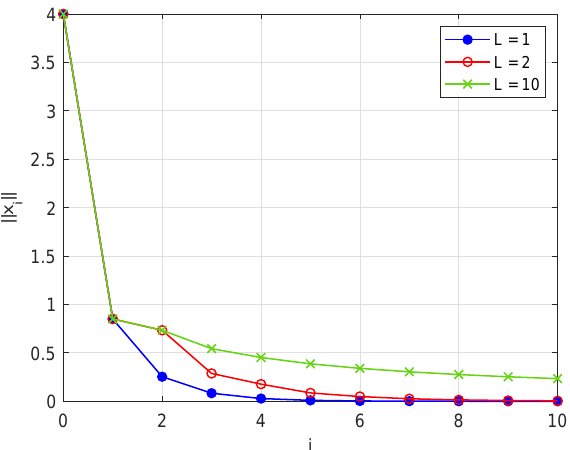
Figure 3. The state vector norms of the DDFL system (1), (93) with α = 0.4 and the DSF (79), (105) for x 0 = [ 1 4 2 ] and different values of